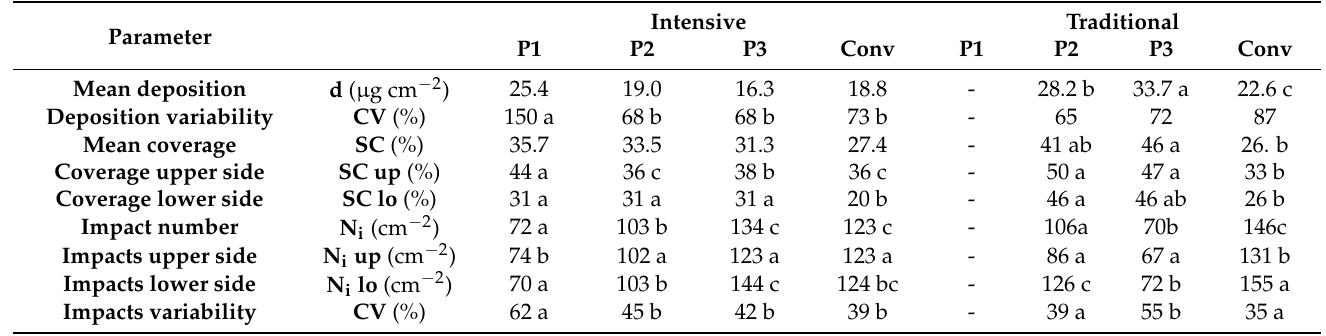
Table 5. Spray deposition and coverage parameters for the different sprayers in the two cultivation systems. Letters after figures indicate the post-hoc test homogeneous group in the case statistically significant differences were